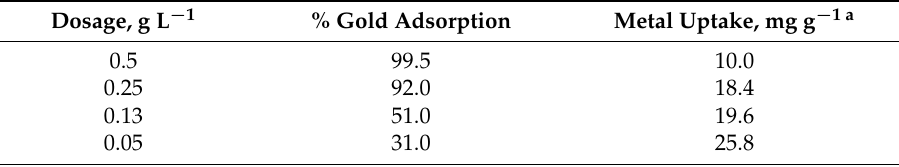
Table 6. Influence of nanotubes dosage on gold(III) adsorption.